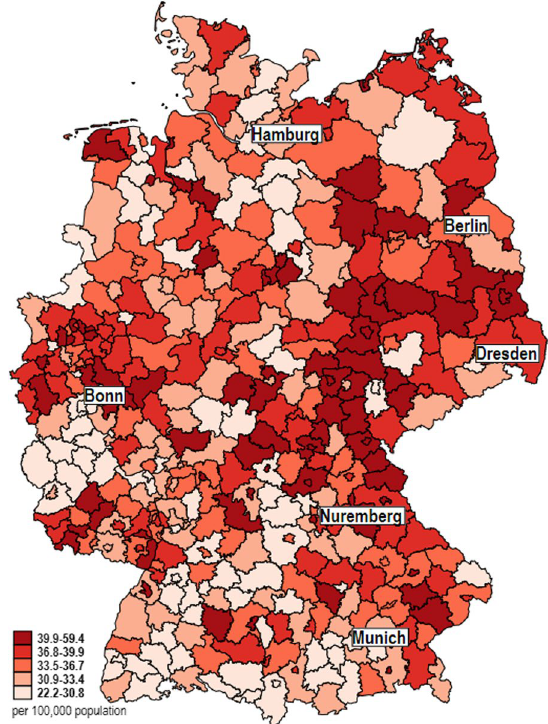
Fig. 4 Distribution of the stroke mortality rate of districts and district-free cities in